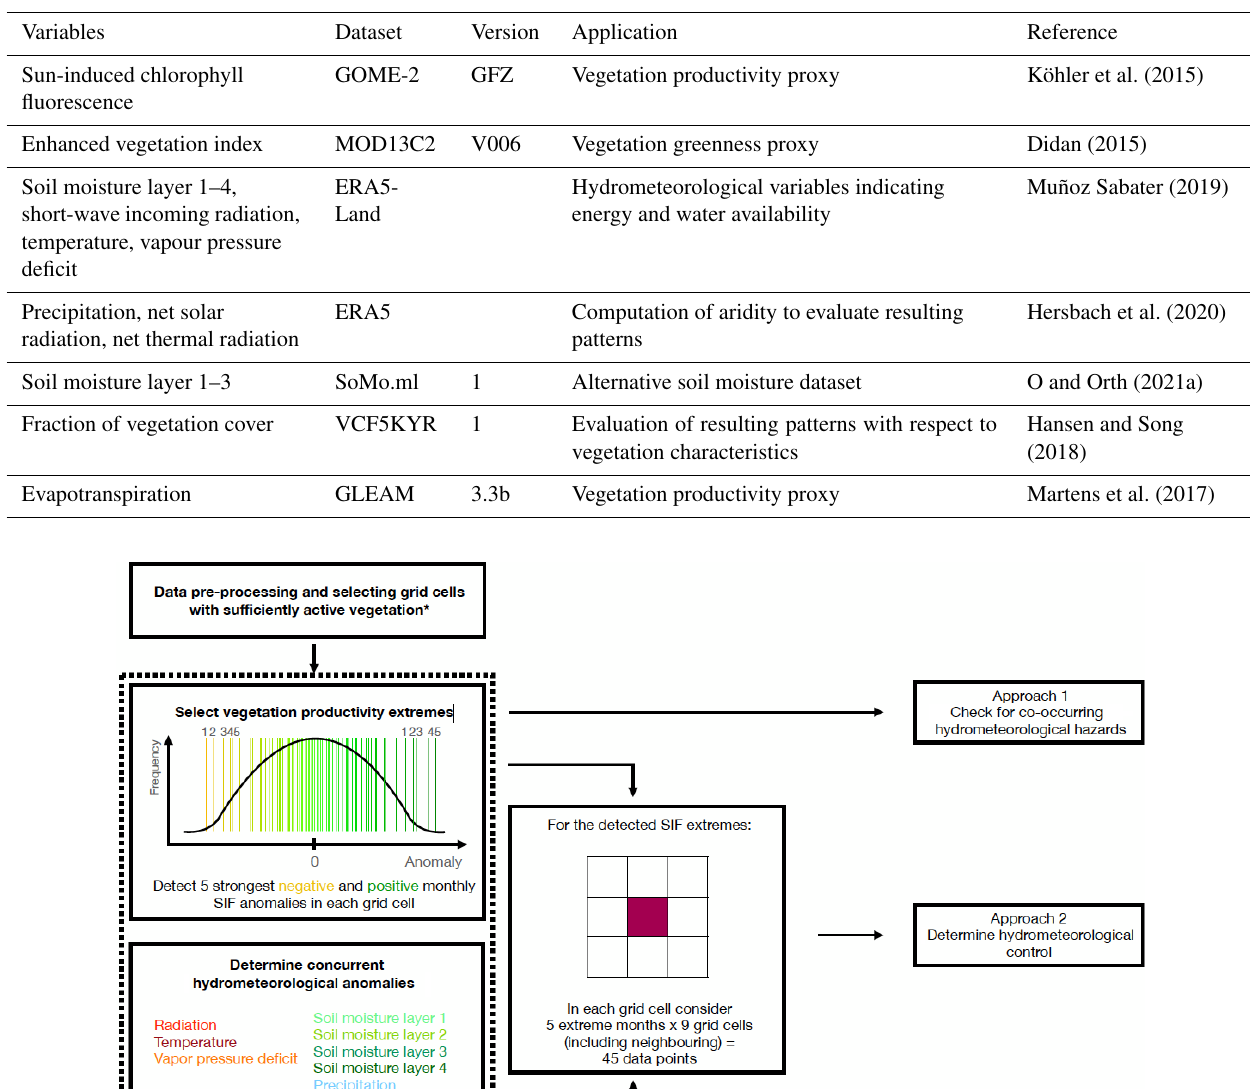
Table 1. Datasets used in this study. GLEAM: Global Livestock Environmental Assessment Model. GFZ: German Research Centre for Geosciences. VCF: vegetation continuous fields.